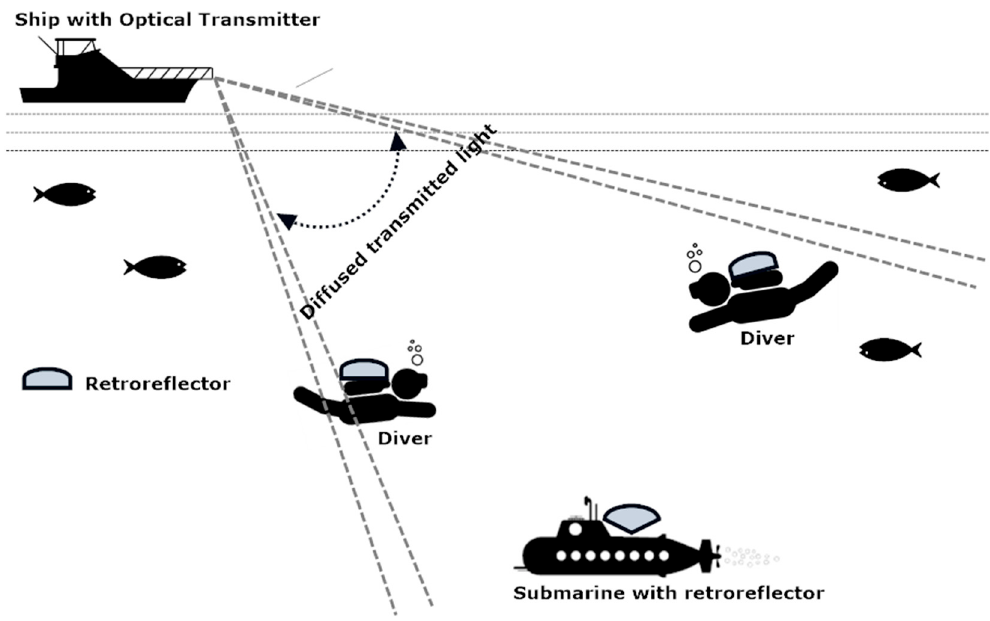
Figure 3. Optical tracking-based aquatic communication model.